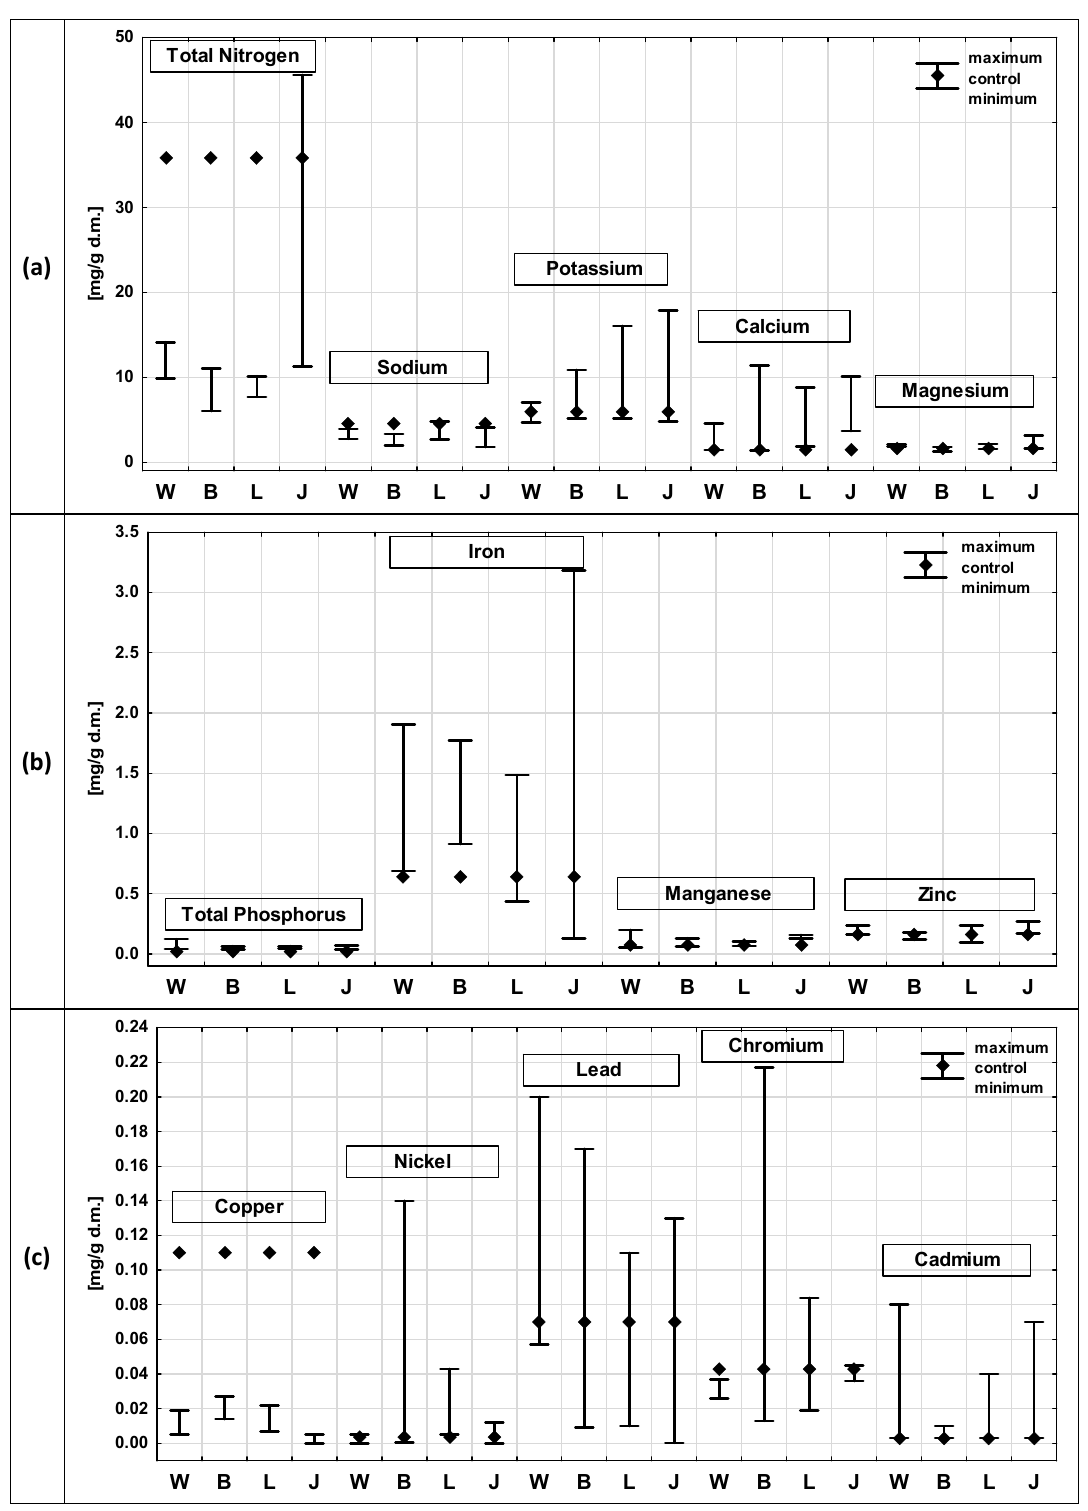
Figure 3. Comparison of chemical composition of plants after exposure to leachate from active (L—Legnica, J—Jawor) and closed (W—Wrocław, B—Bielawa) landfills with the composition of the control sample—results of analyses for Phragmites australis roots: ( a ) contents of TN, sodium, potassium, calcium and magnesium; ( b ) contents of TP, iron, manganese and zinc; ( c ) contents of copper, nickel, lead, chromium and cadmium.